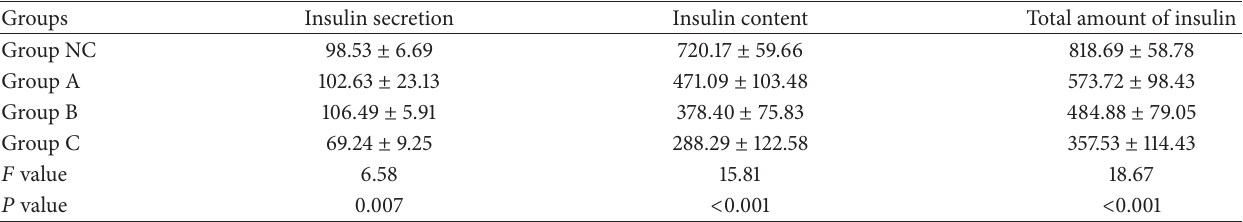
Table 3: Effects of simvastatin on insulin content, secretion in MIN6 cells, and total insulin at high glucose levels (mean ± SD, 𝑛 = 6 , 𝜇 IU/mg protein).